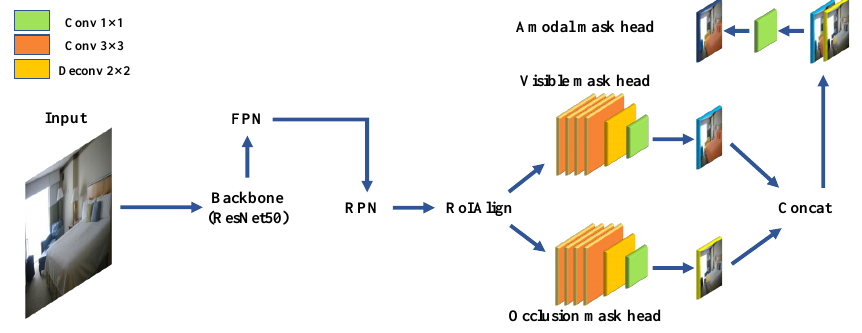
Figure 2. The architecture of